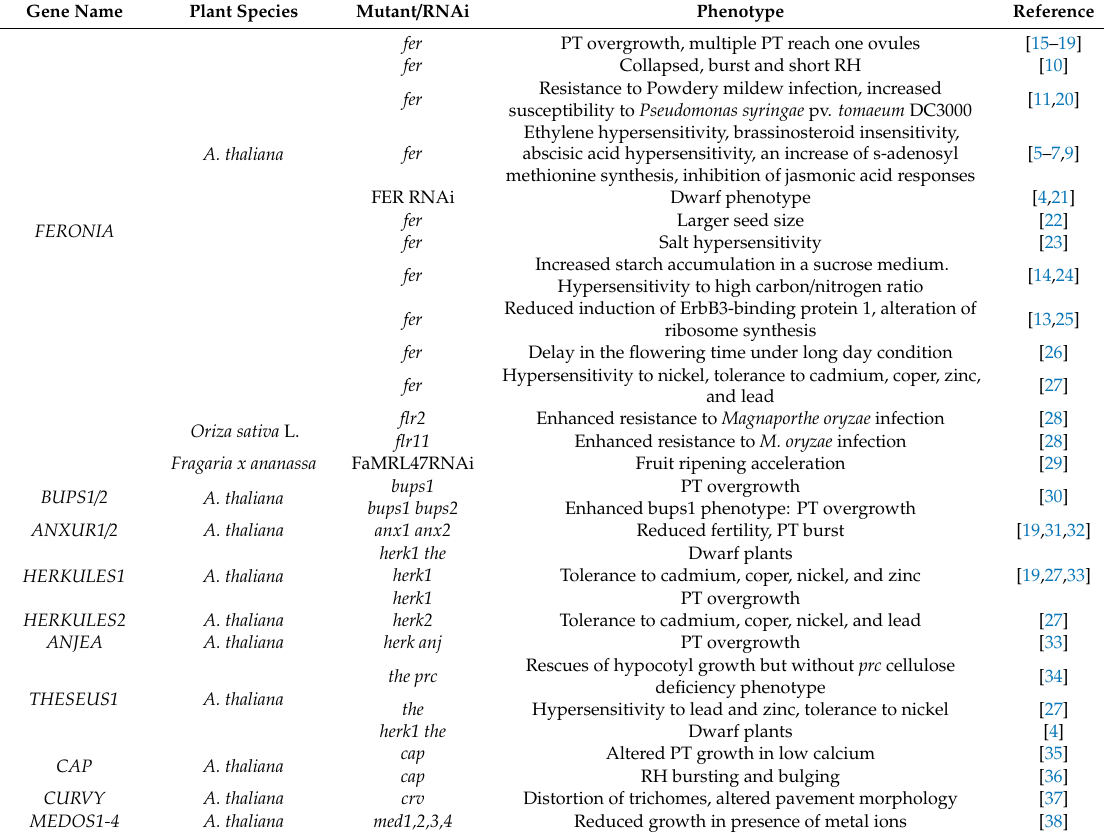
Table 1. CrRLK1L genes studied in di ff erent plant